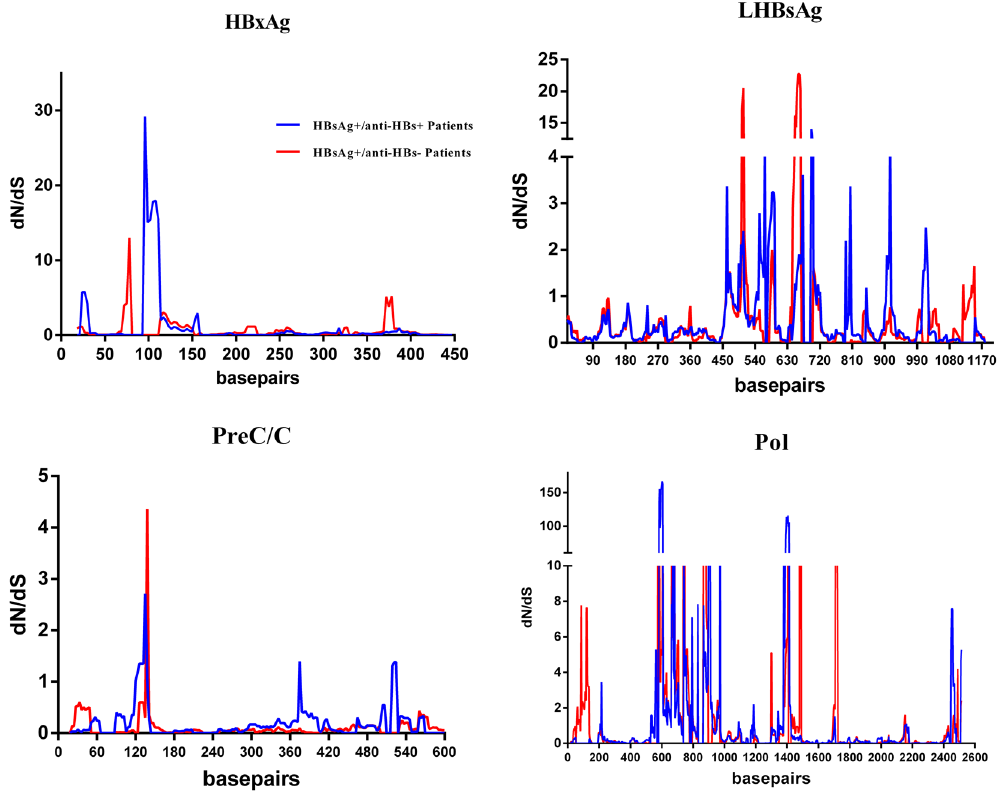
Figure 5. dN/dS in four genes (LHBsAg, Pol, HbxAg, and PreC/C) were verified by a sliding windowanalysis using the Nei-Gojobori distance estimation method (window length, 15 nt; window step, 3 nt).